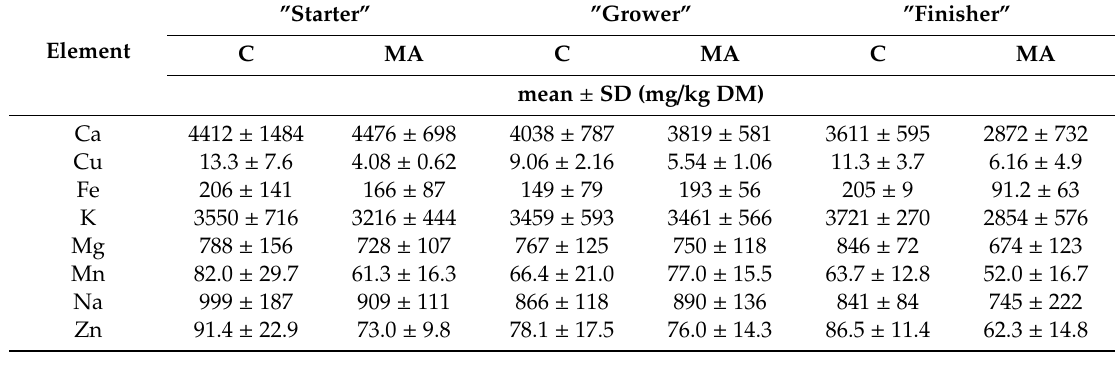
Table 3. The mineral composition of the feed for pigs in the control and experimental groups (Data from Michalak et al., Open Chem., De Gruyter Open, 2015 [18]).